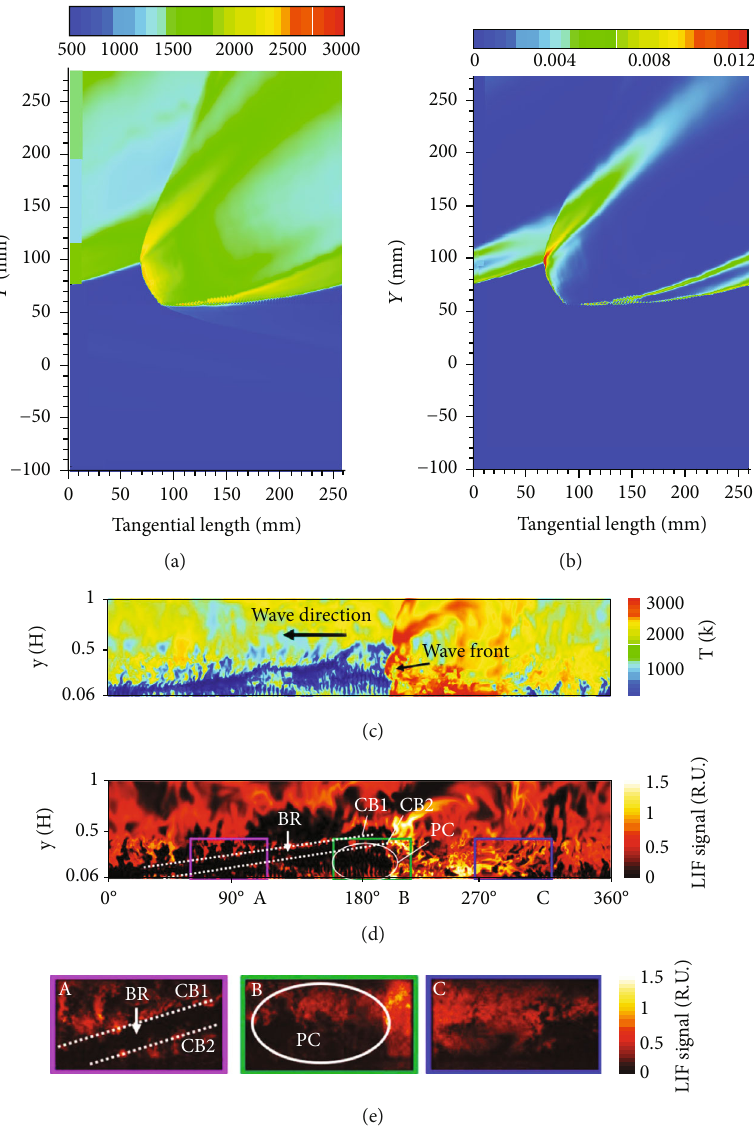
Figure 6: Comparisons of the results between the present simulation and results in the literature: (a) unwrapped temperature contour of case 1; (b) unwrapped OH contour of case 1; (c) unwrapped temperature contour of LES [58]; (d) unwrapped OH contour of LES [58]; (e) OH-PLIF images obtained from the experiment